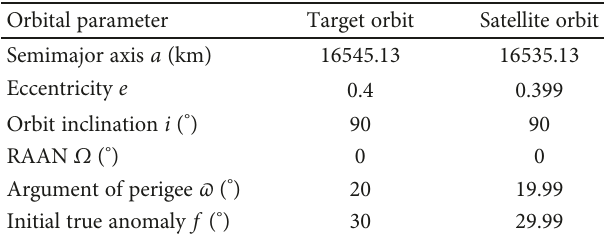
Table 1: Initial orbit parameters of the satellite and